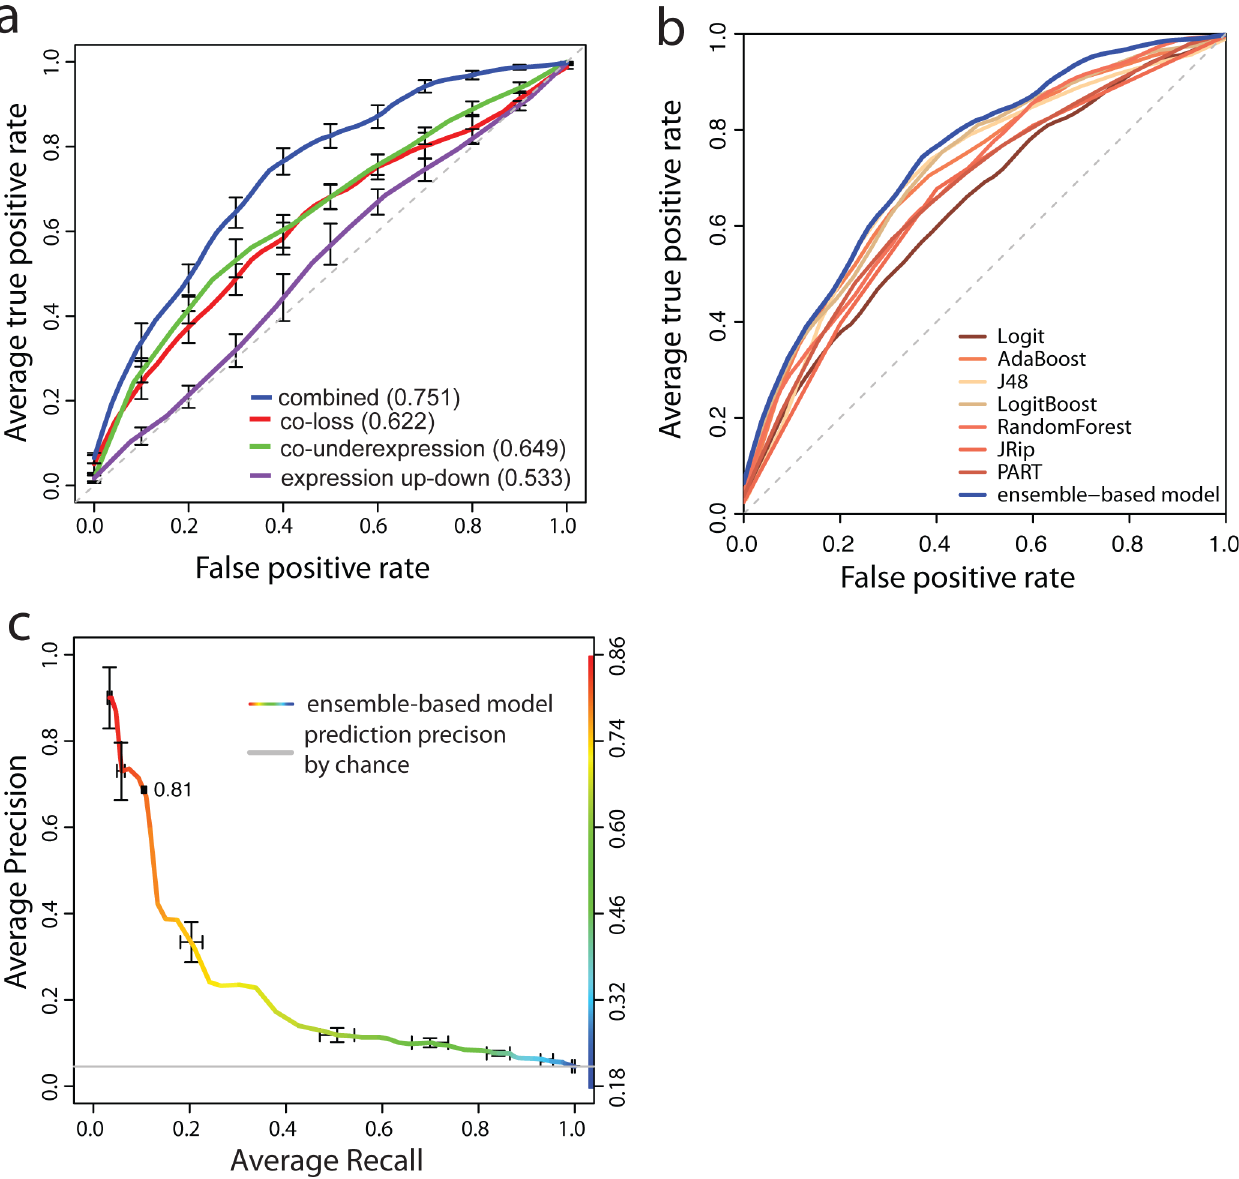
Fig 4. Receiver operating characteristic (ROC) curves. (a) The ensemble-based prediction model based on all five combined patterns has an area under curve (AUC) of 0.75 (blue line), which is estimated by 10-fold cross validation. Ensemble-based prediction models based on the non-combined individual patterns, i.e., co-loss in CNVs, co-underexpression and expression up-down, are shown in red, green and purple respectively, and have lower AUCs. Standard error bars are added to each ROC. (b) The ensemble-based prediction model (the blue ROC curve) has a better performance than all the seven single. (c) The precision and recall curve is estimated from 10-fold cross validation. Standard error bars are added. The curve is colored according to the cutoff of probability. The color panel of the probability is plotted at the right side. The cutoffs of probability scores ( p ( x )), 0.81, are printed at the corresponding curve positions. The grey line represents the prediction precision by chance